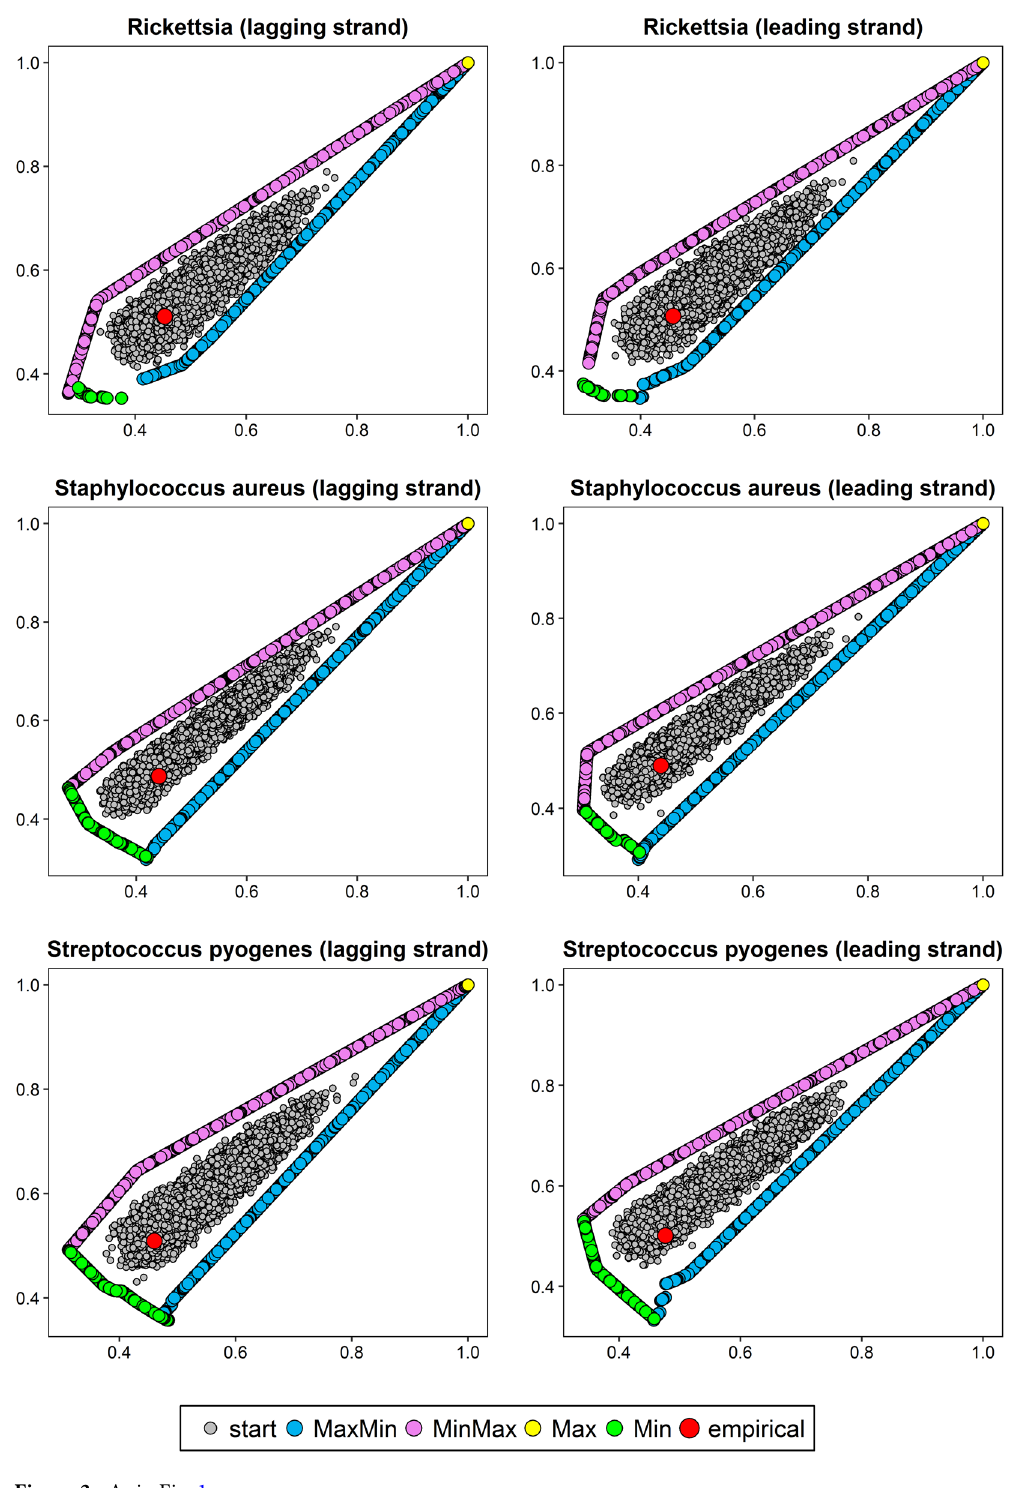
Figure 3. As in Fig.